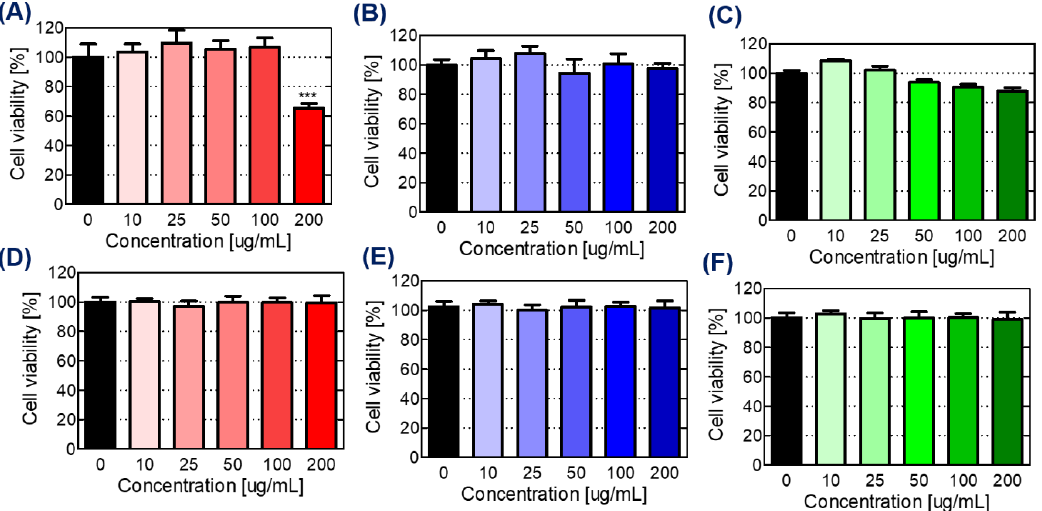
Figure 3. Cytotoxicity of studied materials against the hADMSCs. ( A – C ) hADMSCs viability measured after 24 h, and ( D – F ) hADMSCs viability measured after 14 d. Nano-scaffolds; ( A , D ) Fe 3 O 4 ( B , E ) SCB-H, and ( C , F ) SCB-H@Fe 3 O 4 . *** p < 0.001.